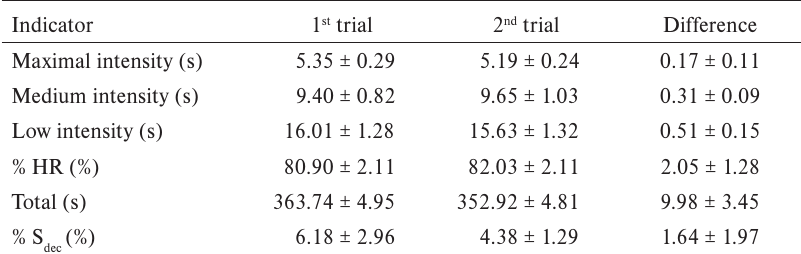
Descriptive statistics of the test (M ± SD)